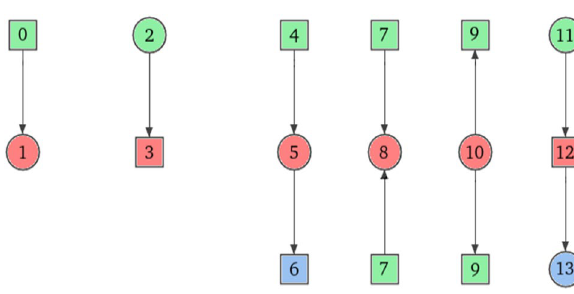
Figure 9. First six pn-graphlets with orbits counted in Table 2.